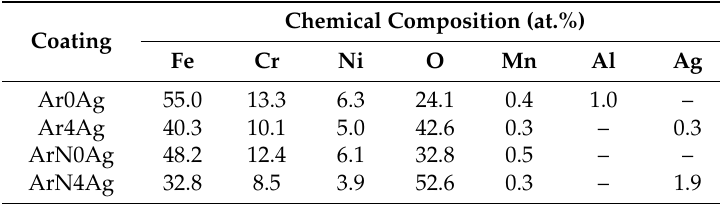
Table 4. Results by means of the energy dispersive X-ray spectroscopy (EDS) analyses of wear tracks. Chemical Composition (at.%) Coating Fe